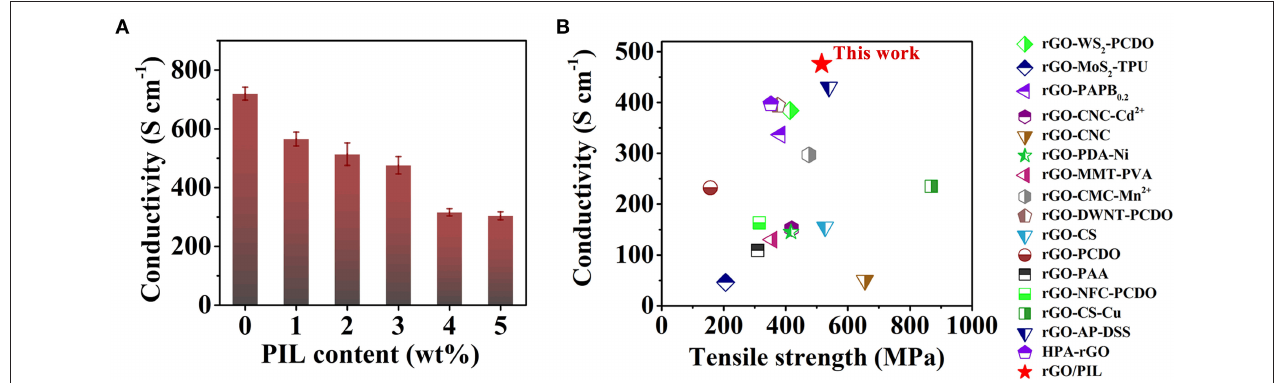
FIGURE 4 | (A) The electrical conductivity of rGO/PIL- x %, x = 0 to 5, rGO/PIL-0% is rGO film. (B) Comparison of mechanical and electrical properties of rGO/PIL-3% and other rGO-based nanocomposites known in literature. GO, graphene oxide; rGO, reduced graphene oxide; PIL, poly(1-benzyl-3-vinylimidazolium